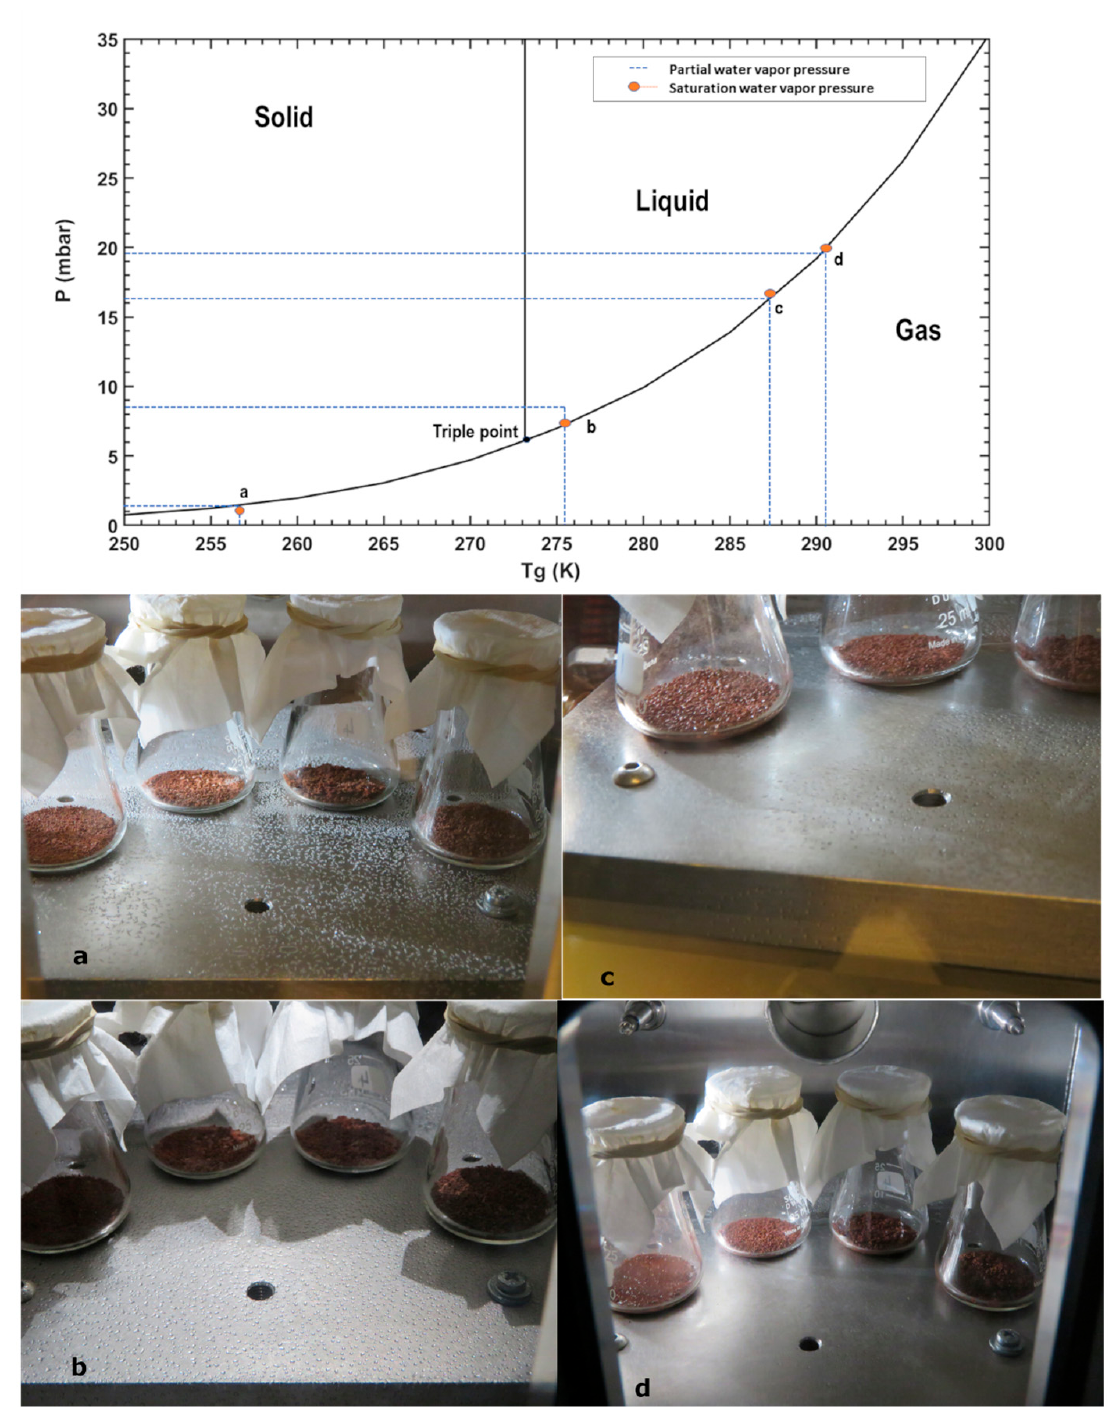
Figure 7. (Top) Environmental P, Tg conditions, during this experiment, the surface RHg was 100%, and the air was always drier. (Bottom) Images of the sample taken at different time intervals show the different phase transitions of water droplet formation and evaporation and the mixture of soil simulant with salts. ( a ) When the table temperature Tg reached 251 K, the frost started to form. ( b ) As the table temperature Tg passed through the triple point at 274 K, the liquid water droplets were formed. ( c ) These droplets were stable till 283 K, and they started evaporation on the sides. ( d ) All the tiny droplets were evaporated at 287 K, whereas some relatively large droplets were extracted through a syringe after the chamber door was open.